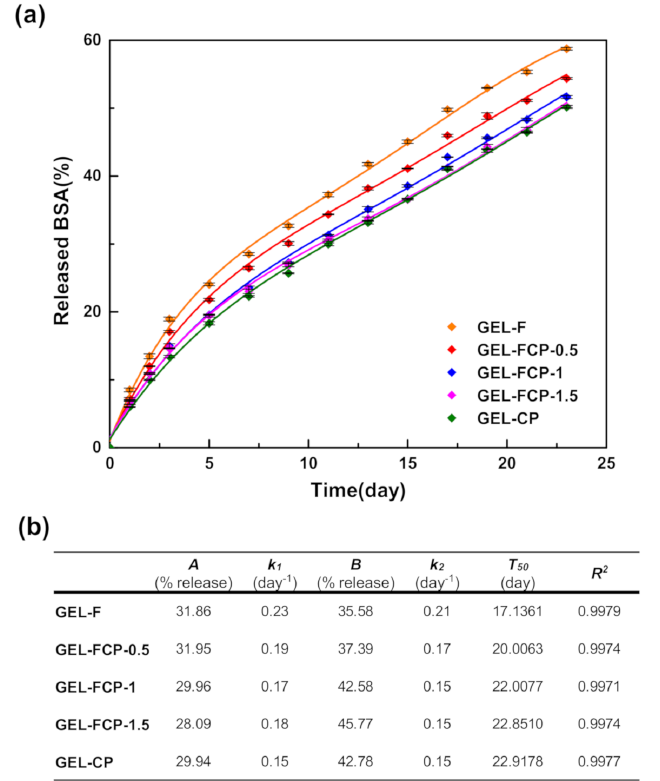
Figure 6. ( a ) Cumulative bovine serum albumin (BSA) release for 21 days ( n = 5). The lines drawn represent nonlinear regression fit according to Equation (1). ( b ) Fitted parameters of each hydrogels.